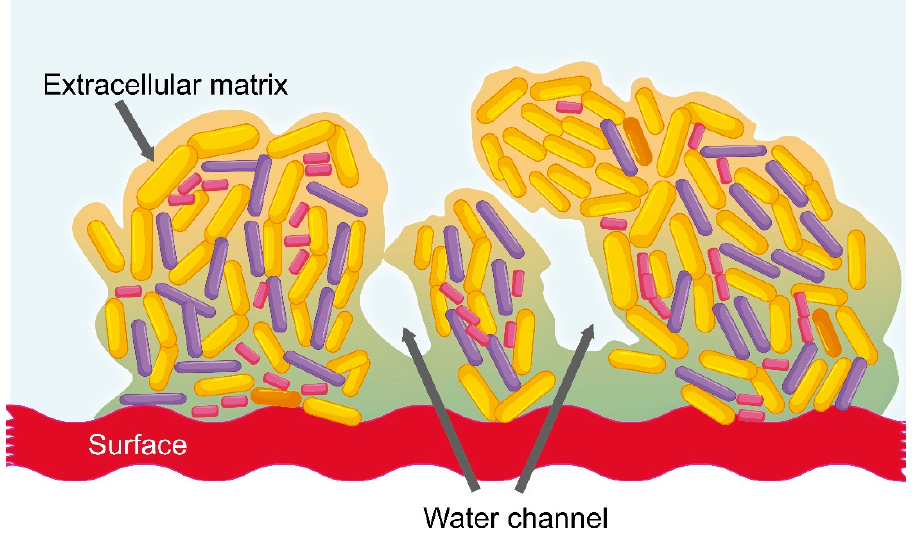
Figure 1. Proposed architecture of the biofilm as a mechanism of resistance of bacteria (see text for details).